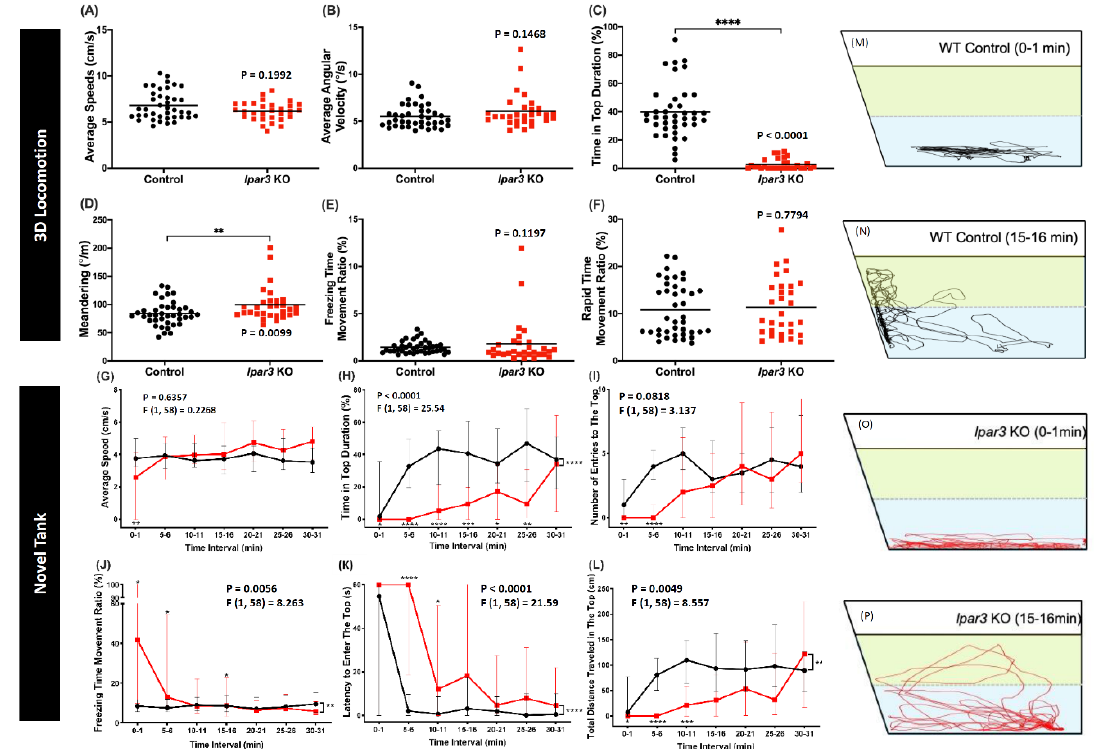
Figure 2. Comparison of behavior endpoints between wild-type (black) and lpar3 KO (red) fish in 3D locomotion ( A – F ) and novel tank ( G – P ) tests. In the 3D locomotion test, average speed ( A ), average angular velocity ( B ), time-in-top duration ( C ), meandering ( D ), freezing time movement ratio ( E ), and rapid movement ratio ( F ) were analyzed. The data are expressed as the median and were analyzed by the nonparametric Mann–Whitney test ( n = 40 for control; n = 30 for lpar3 KO fish). Average speed ( G ), time-in-top duration ( H ), the number of entries to the top ( I ), freezing time movement ratio ( J ), latency to enter the top ( K ), and total distance traveled in the top ( L ) were analyzed during a novel tank test. Locomotor trajectories are expressed in the wild type before ( M ) and after acclimation ( N ) and in lpar3 KO fish before ( O ) and after acclimation ( P ). The data are expressed as the median with interquartile range and were analyzed by two-way ANOVA with Geisser–Greenhouse correction. To observe the differences between time interval, Sidak’s multiple comparison test was used ( n = 30 for both groups; * p < 0.05, ** p < 0.01, *** p < 0.001, **** p < 0.0001).